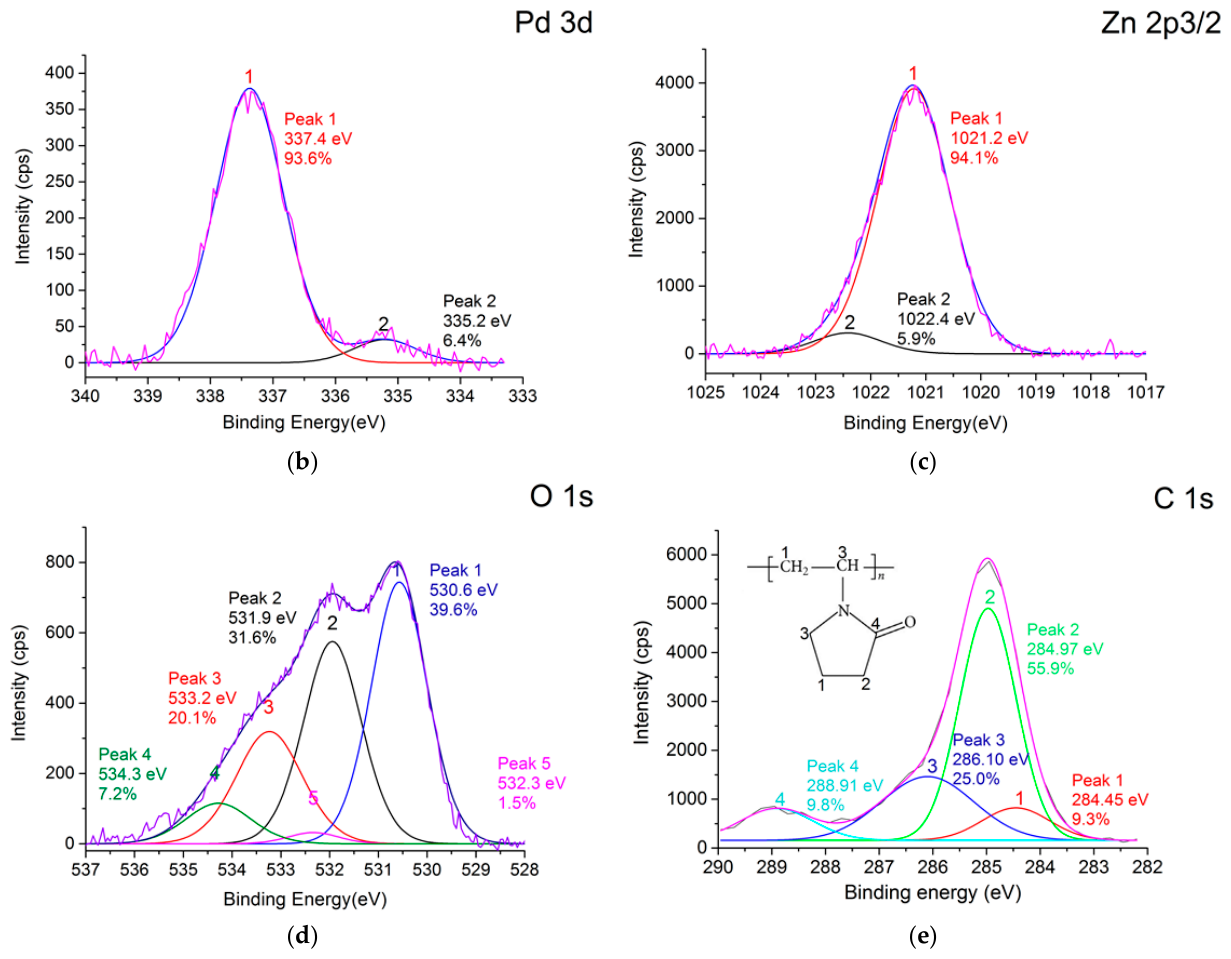
Figure 6. The XPS results in data for the 0.5%Pd-PVP/ZnO catalyst: survey XPS spectrum ( a ) and curve-fitted XPS spectra of the Pd (3d) ( b ), Zn (2p3/2) ( c ), O (1s) ( d ) and C (1s) ( e ) regions.